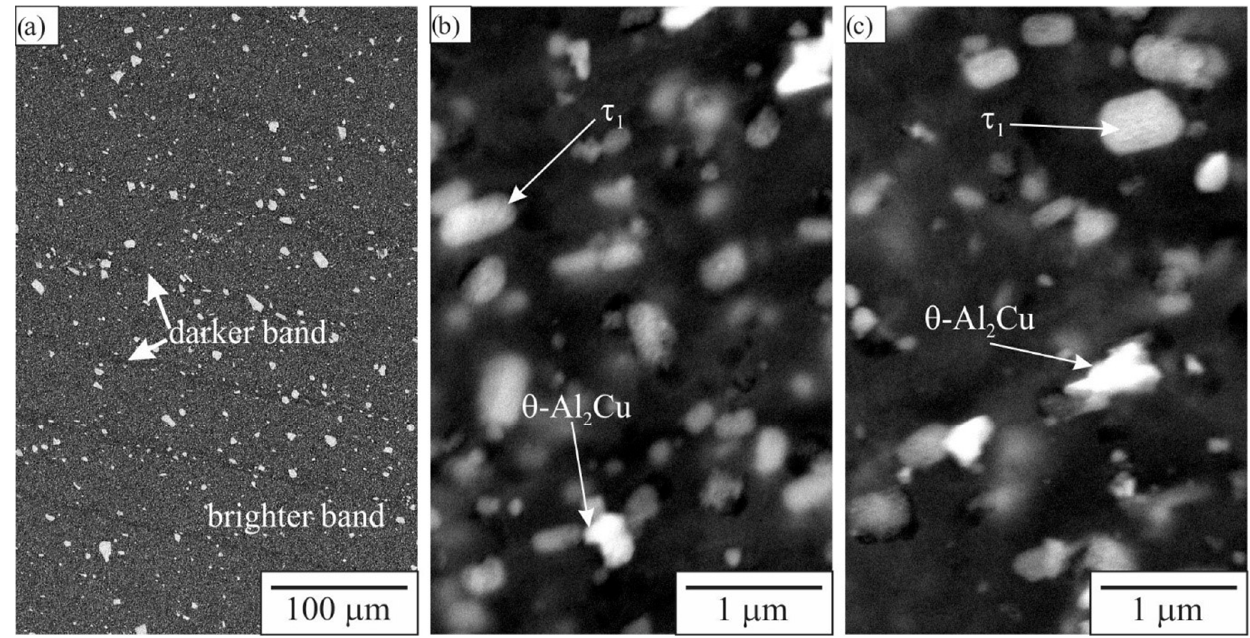
Figure 7. Microstructure in the stir zone (BSE) of sample FSP950, area A in Figure 2: ( a ) onion structure, consisting of wider brighter and thinner darker bands, ( b ) distribution of particles in a brighter band, ( c ) distribution of particles in a darker band.